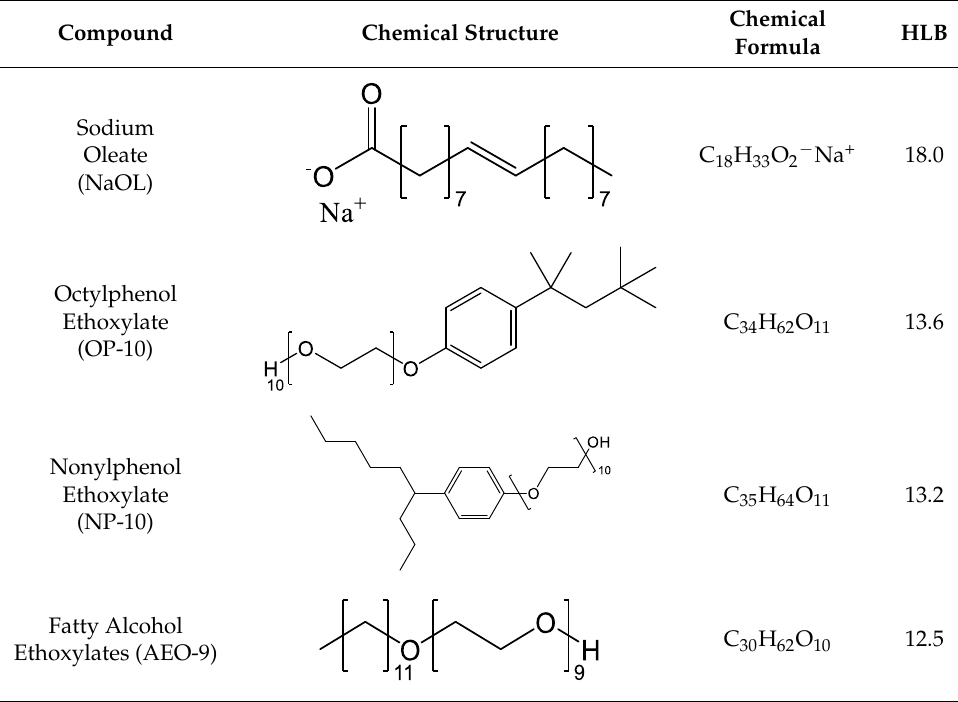
Figure 1. The size distribution of quartz used in flotation. Table 1. The chemical structures, chemical formula and HLB values of NaOL, OP-10, NP-10 and AEO-9.